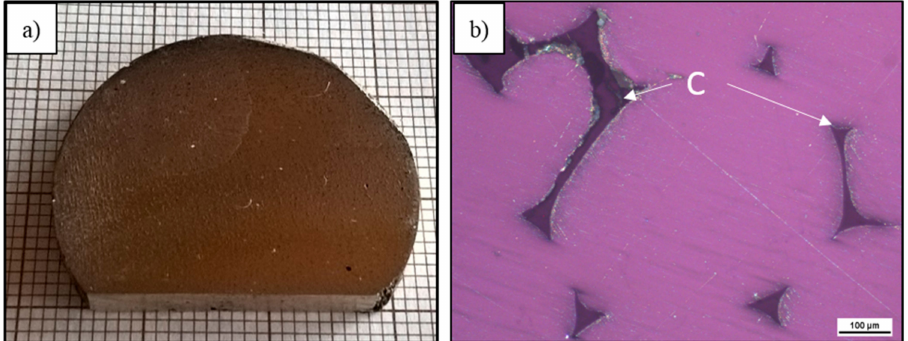
Figure 2. ( a ) Macrograph and ( b ) LM micrograph of C of –Mg composite obtained by pressure